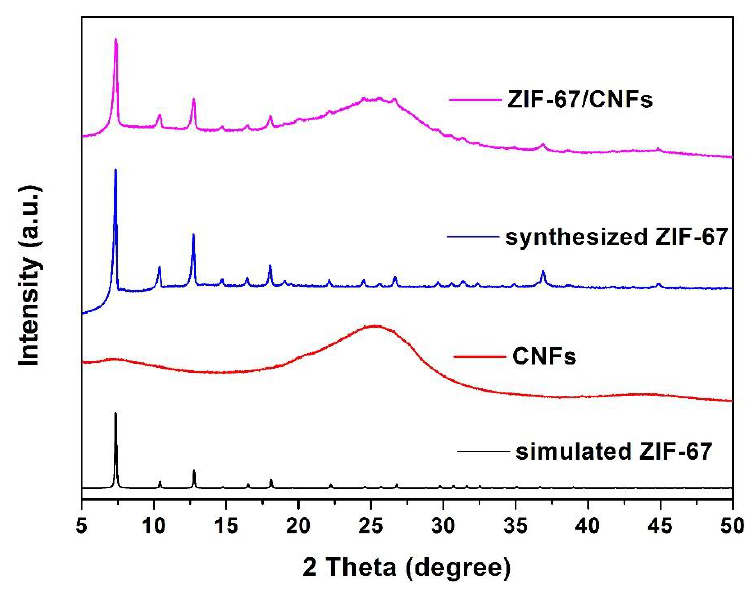
Figure 3. XRD patterns of simulated ZIF-67, CNFs, synthesized ZIF-67, and ZIF-67/CNFs composite.